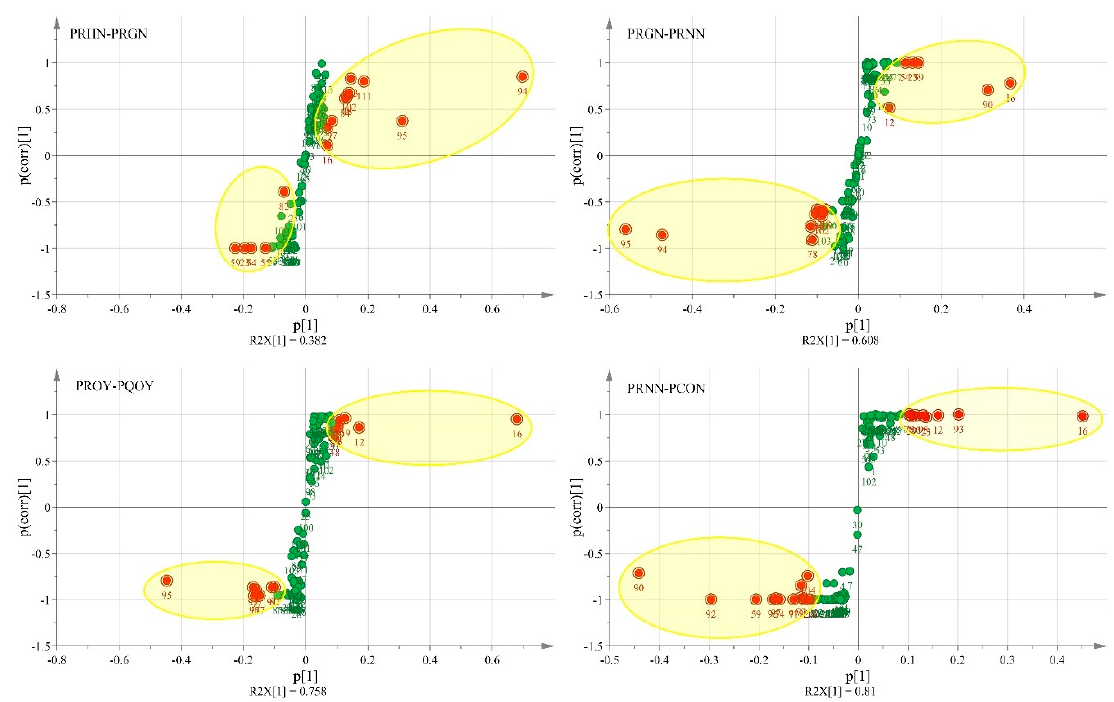
half-net room (PRHN) and little-net room (PRGN) cultivation modes, of which four com- pounds had VIP >2, namely, valencene (80), limonene (14), 3,7-dimethyl-2,6-octadienal (50), and intermedeol (95). Nine differential VOCs were present in the little-net room (PRGN) and big-net room (PRNN) oranges, of which the 3 compounds with VIP >2 were valencene (80), limonene (14), 4a-dimethyl-6-(prop-1-en-2-yl)-1,2,3,4,4a,5,6,7-octahy- dronaphthalene (76). Ten differential VOCs were present in Red River Orange Team 38 (PROY) and Qingping Township (PQOY), of which two compounds with VIP > 2 were